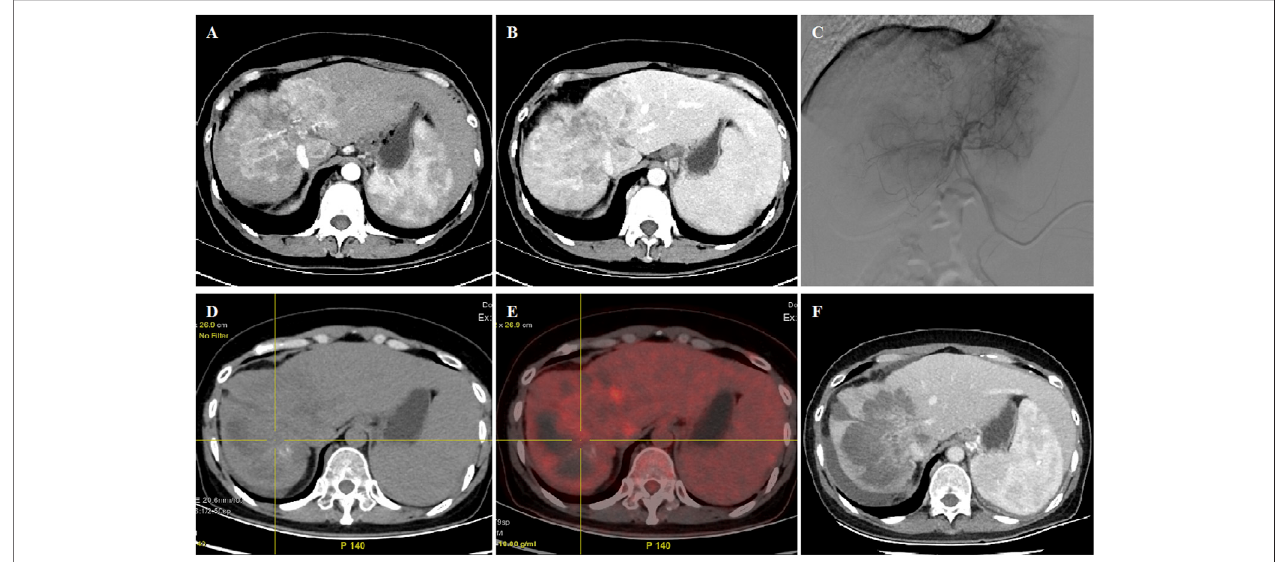
FIGURE 1 | 45 year old female patient treated with CalliSpheres beads for advanced primary HCC. (A – B) CT examination on admission revealed HCC in the right lobe. (C) Hugetumorstainingwasshownandwasembolizedby300 – 500 μ moxaliplatin-loadedbeads. (D – E) PET-CTshowedsigni fi cantreductionofthetumorandno residual tumor at 2.2 months ’ follow-up. (F) Complete response was shown by mRECIST criteria at 5.0 months ’ follow-up and still alive 15.5 months later.